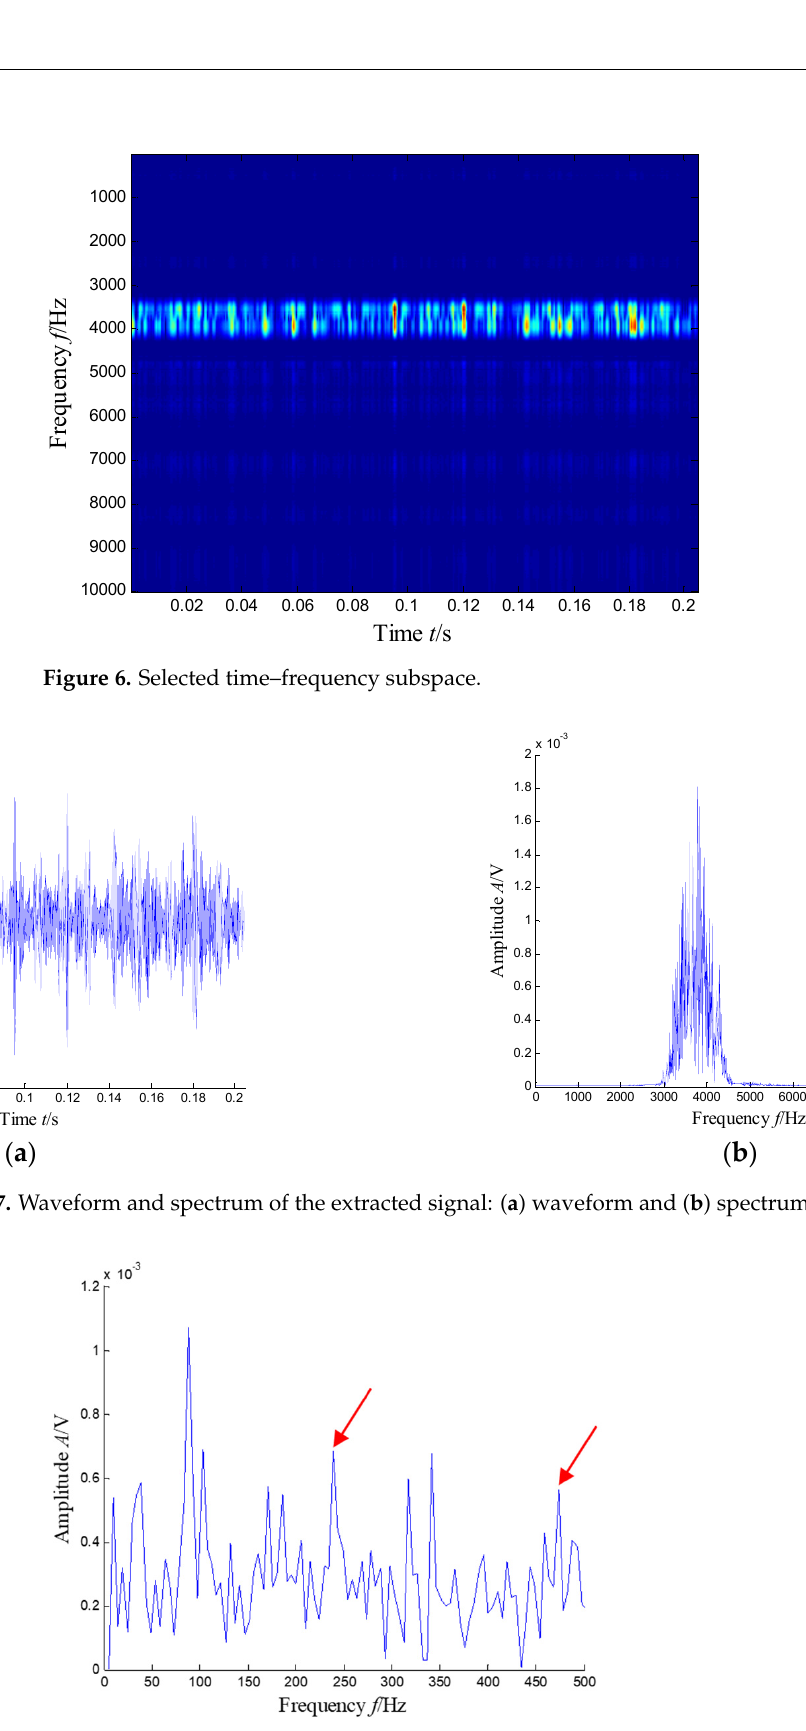
Figure 8. Envelope spectrum of the extracted signal (the first two order harmonics of f BPFO are highlighted by two red arrows).